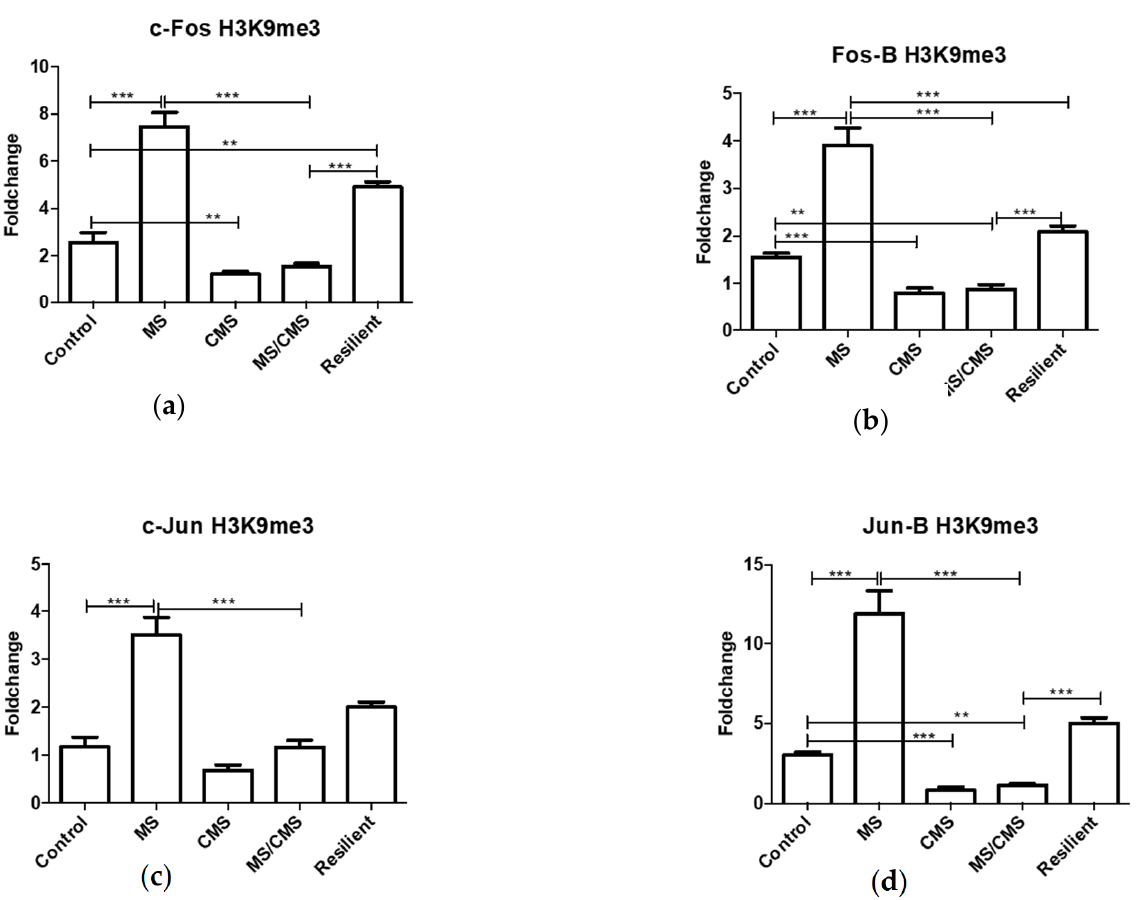
Figure 5. Association of histone H3 lysine 9 trimethylation (H3K9me3) with different IEG promoters: ( a ) c-Fos; ( b ) Fos-B; ( c ) c-Jun; ( d ) Jun-B Results presented as fold change over a control gene promoter ( Hist1H2BA ). ** = p < 0.01, *** = p ≤ 0.001. Data shown as mean fold change +/ − SEM.